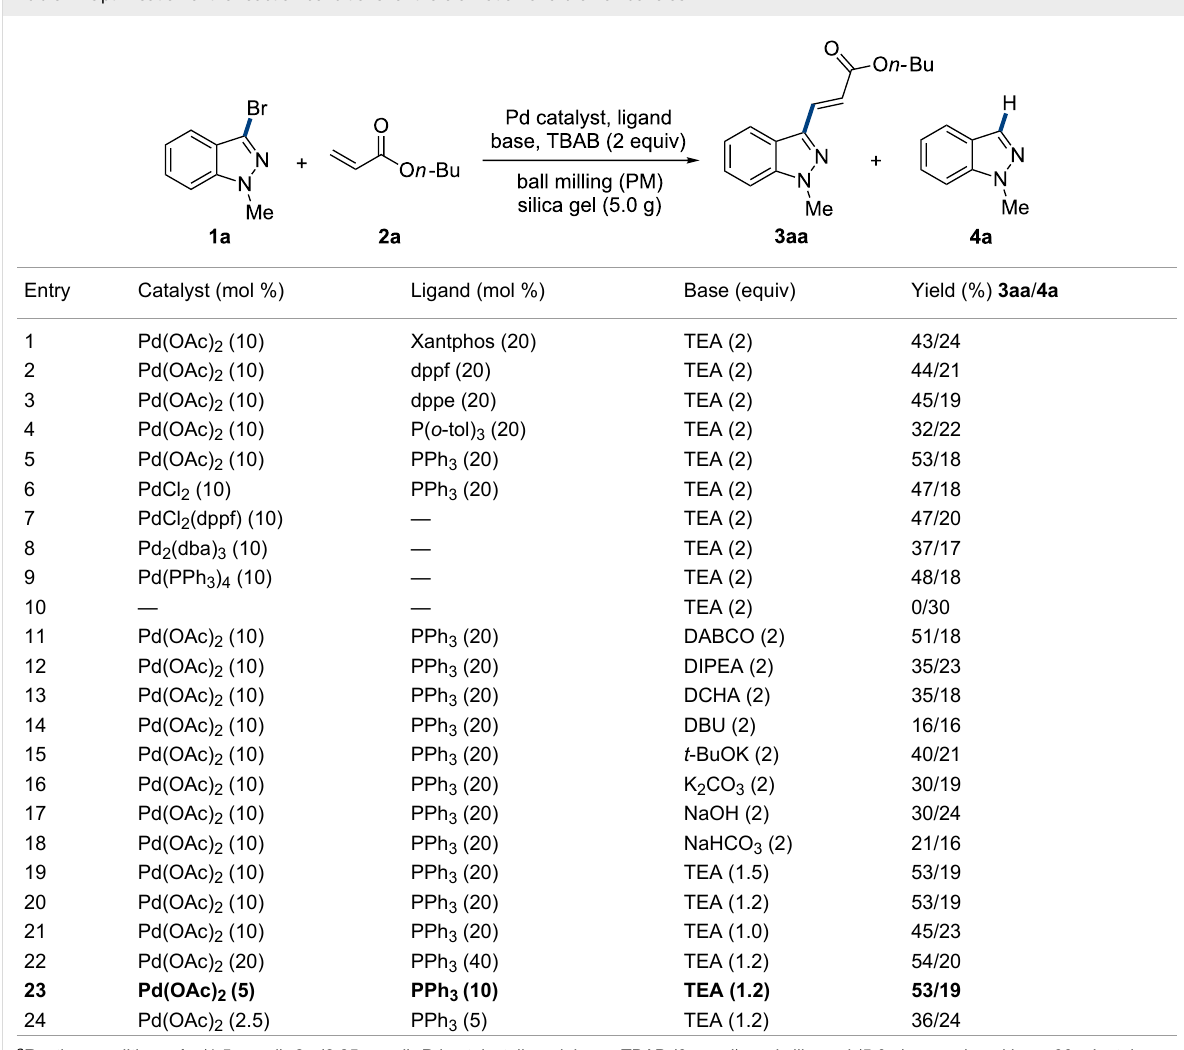
Table 1: Optimisation of the reaction conditions for the olefination of 3-bromoindazoles.